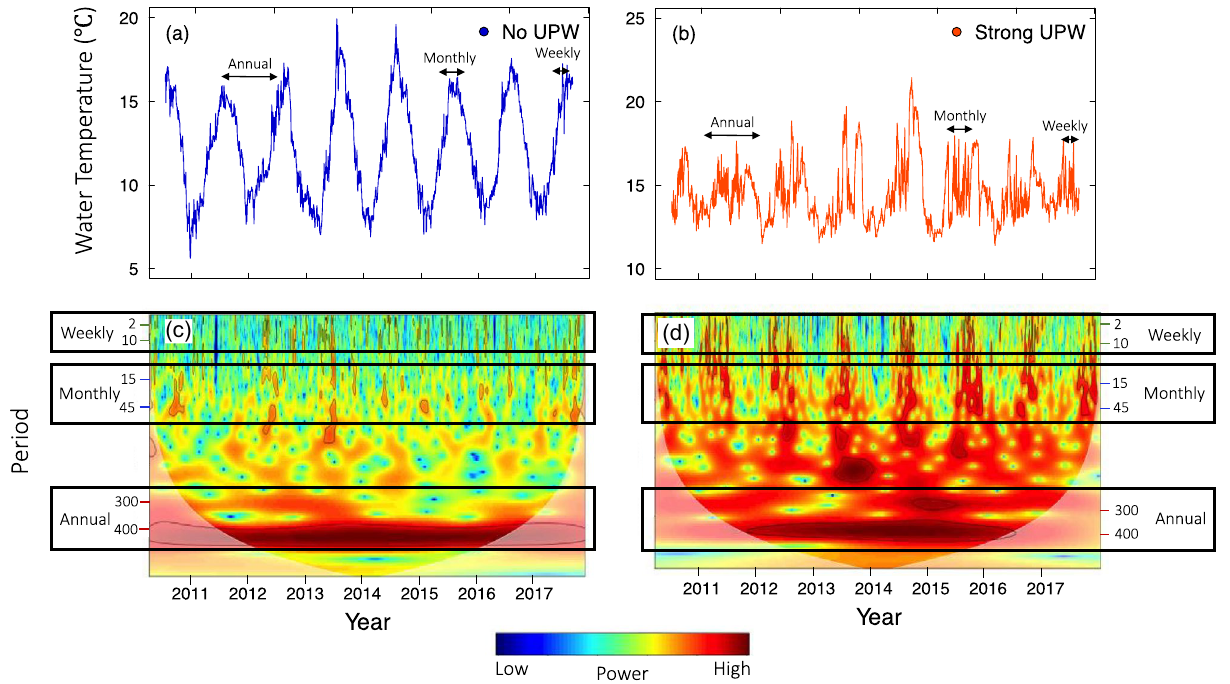
Figure 2. Time series and wavelet analysis of onshore water temperature across a site characterized by no upwelling ( a , c ) and strong upwelling ( b , d ). Wavelet power quantifies the relative contribution of variation in water temperature at each period to the total variance over time. This study compares annual and subannual periodicities to investigate a range of temporal scales that are more relevant to marine organisms (weekly, monthly). High power is represented in warm colors and low power is represented in cool colors. Black contours designate regions of significantly high temporal variation compared to a null model (red noise). The bolder color cone shape represents the cone of influence—values outside of this region are less reliable due to edge